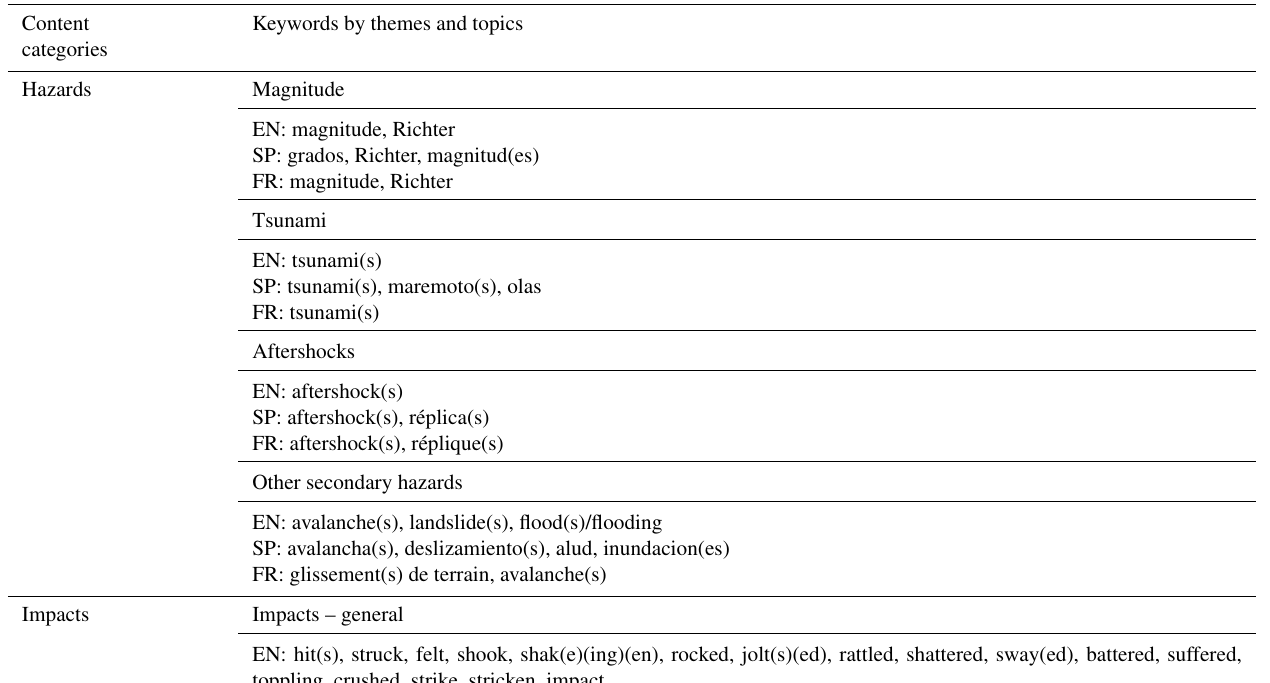
Table 1. Discourse content dictionary. Contains the keywords used to classify news items into categories of discourse corresponding to the main phases and topics of disaster risk management. Keywords were identified from a list of most frequent words using different thresholds for English (EN), Spanish (SP) and French (FR) to balance differences in the RSS feed numbers.